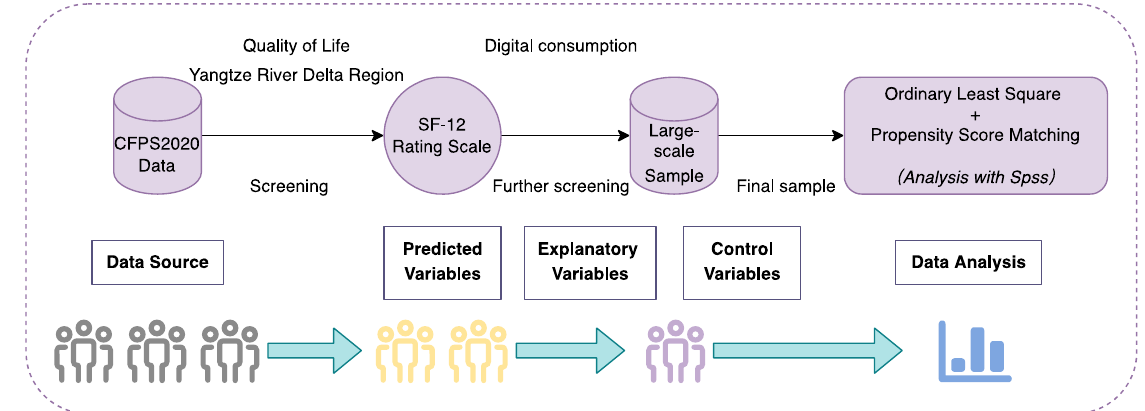
Figure 3. Quantitative study design.